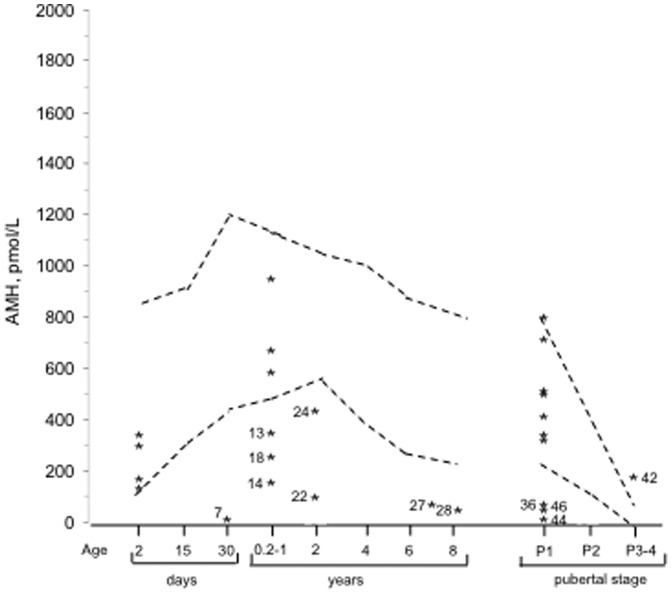
Distribution of the plasma AMH concentrations in 27 boys with isolated hypogonadotropic hypogonadism.Broken lines to the 5th and 95th percentiles [16]. Numbers correspond to low concentrations (Tables 1 and 2): KS in cases 13 and 46, CHARGE syndrome in case 27, FGFR1 mutation in cases 14 and 36 and other HH in the others.